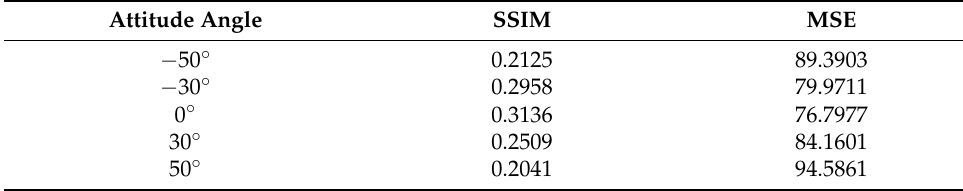
Table 2. The results of image sharpness